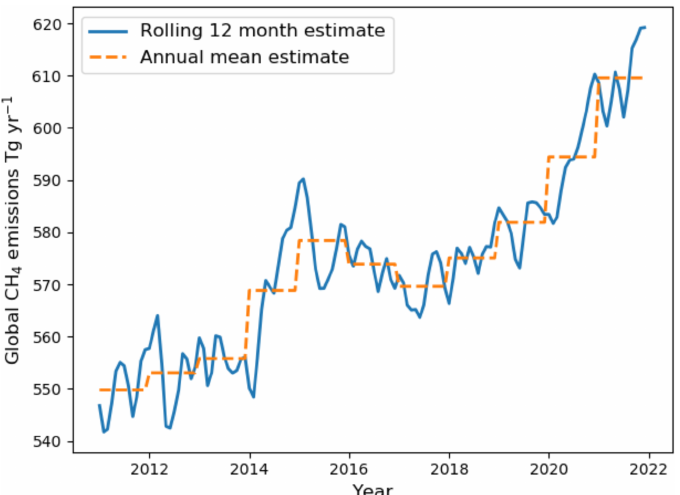
Figure B1. Global box model methane emission estimates between 2011 and 2021, respectively. Emission estimates are based on NOAA global mean surface data. The blue line denotes the rolling 12-month annual emissions, and the orange line denotes the emissions based on annual mean